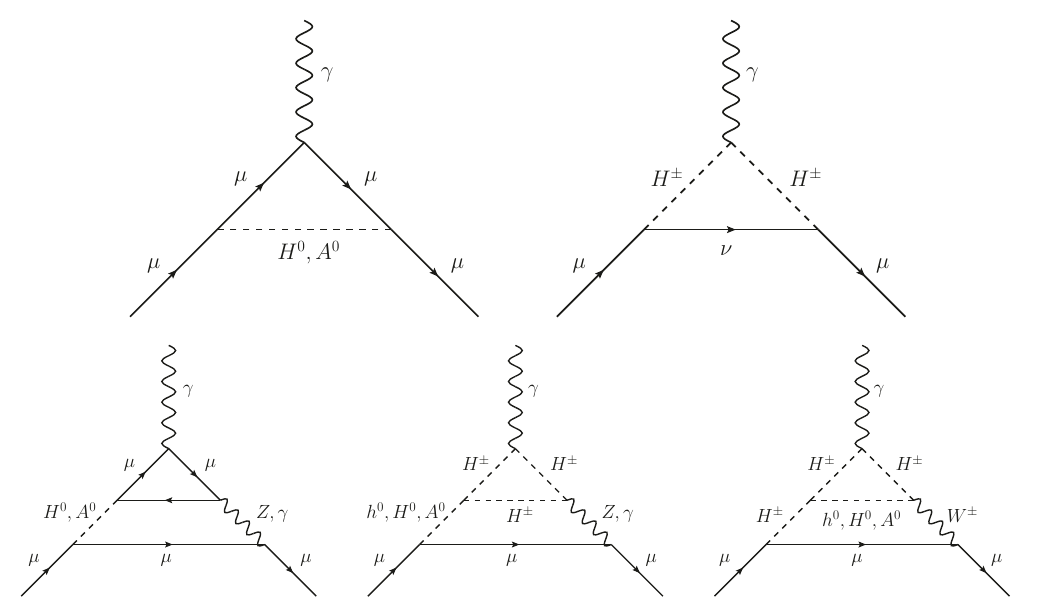
Figure 19. Examples of one- and two-loop 2HDM contributions to µ → µγ